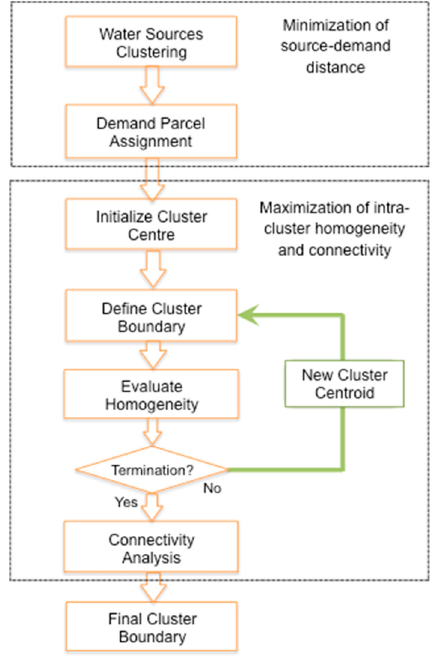
Figure 1. The proposed method for clustering WSS.